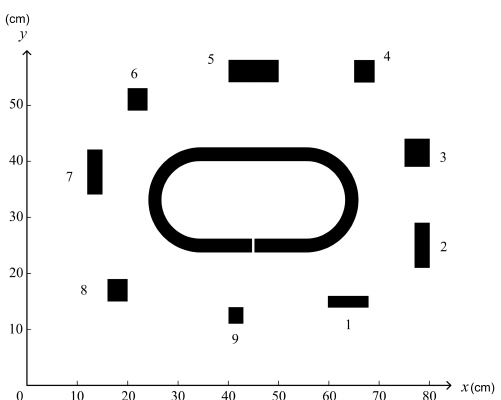
Figure 5. Coordinates of the experimental map.